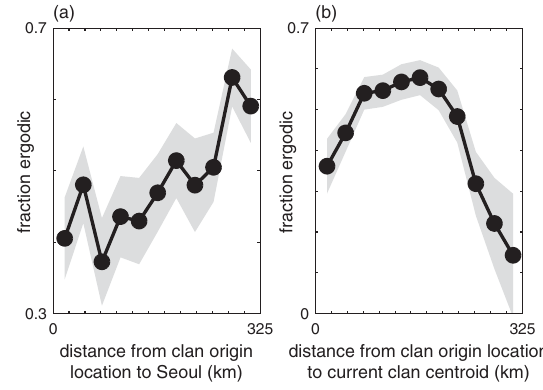
FIG. 5. Fraction of ergodic clans and distance scales of clans. For this figure, we use the 3 900 clans from the 2000 census data for which we were able to identify the origin location (see Appendix D). (a) Fraction of ergodic clans versus distance to Seoul. The correlation between the variables is positive and statistically significant. (The Pearson correlation coefficient is r ≈ 0 . 83 , and the p -value is p ≈ 0 . 0017 .) For the purpose of this calculation, we call a clan “ ergodic ” if it is present in at least 150 administrativeregions. We estimate this fraction separately in each of 11 equally sized bins for the displayed range of distances. The grayregionsgive95% confidence intervals.(b) Fraction ofergodic clans versus the distance between the location of clan origin and the present-day centroid. We measure ergodicity as in the left panel, and we estimate the fraction separately for each range of binned distances. (We use the same bins as in the left panel.) The correlation between the variables is positive and significant up to 150 km ( r ≈ 0 . 94 , p ≈ 0 . 0098 ) and is negative and significant for larger distances ( r ≈ − 0 . 98 , p ≈ 2 . 4 × 10 − 4